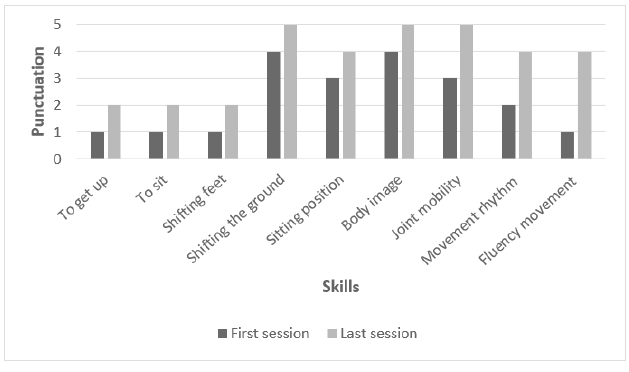
Figure 2. Graph on the progress of the participant by pre- and post-intervention